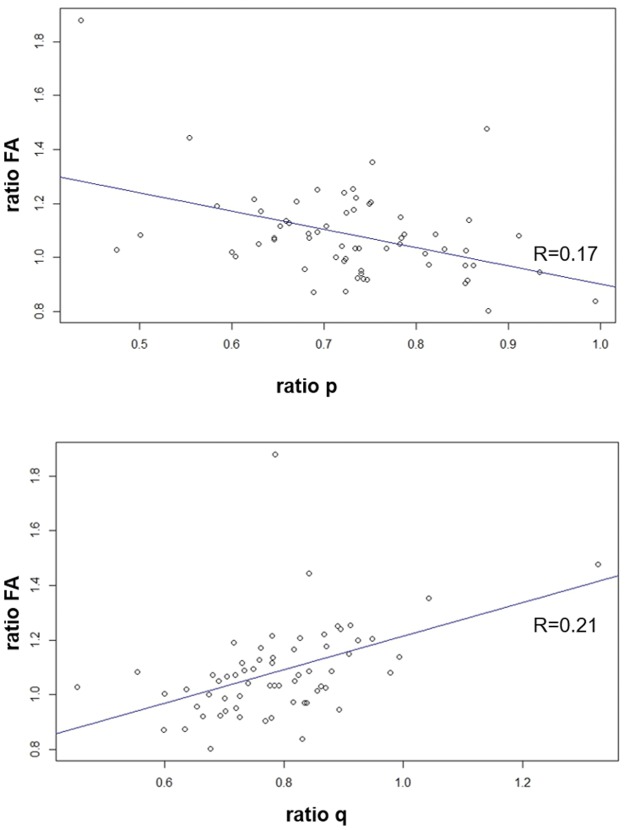
Ratio of FA versus p and q.The ratio of FA is plotted against p and q, showing FA is increasing with increasing q.